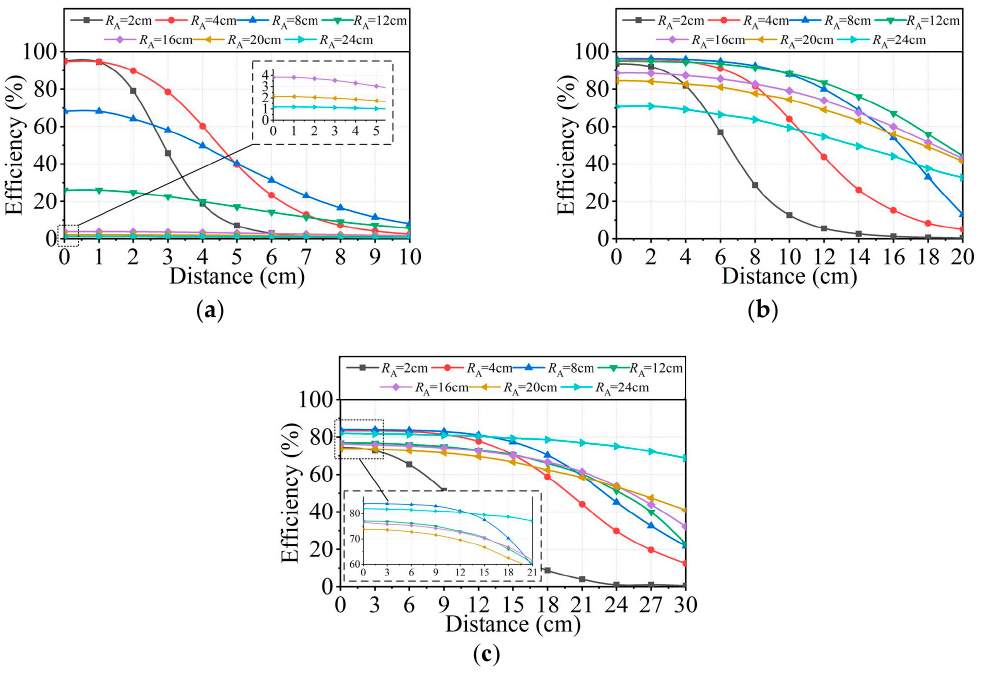
Figure 5. Power transfer efficiency (PTE) curves with different coil radii: ( a ) R A = 2–24 cm, R B = 2 cm; ( b ) R A = 2–24 cm, R B = 5 cm; ( c ) R A = 2–24 cm, R B = 10 cm.